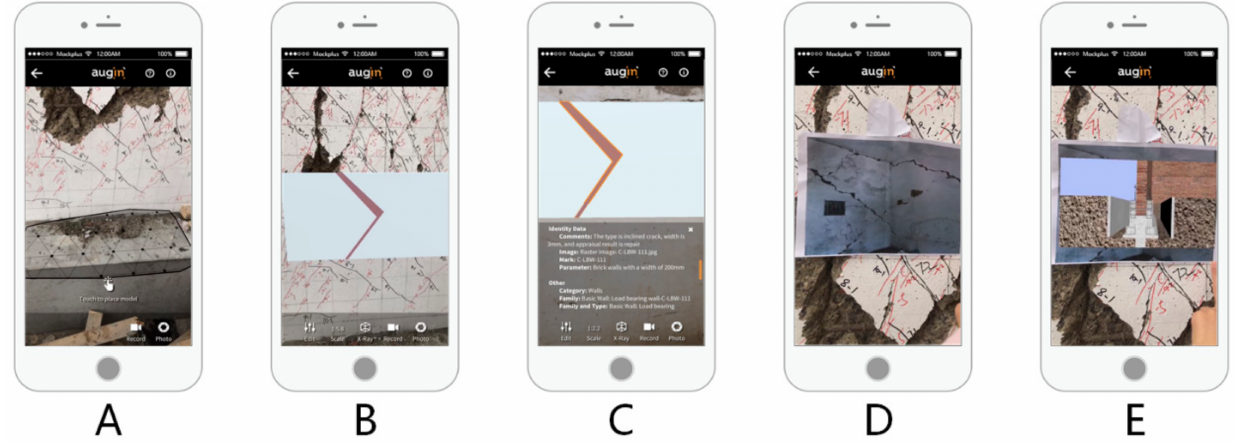
Figure 9. Viewing the BIM information and video: ( A ) Place the model; ( B ) View the model; ( C ) View detailed information of damage; ( D ) Identify the thumbnail; ( E ) Display the video.